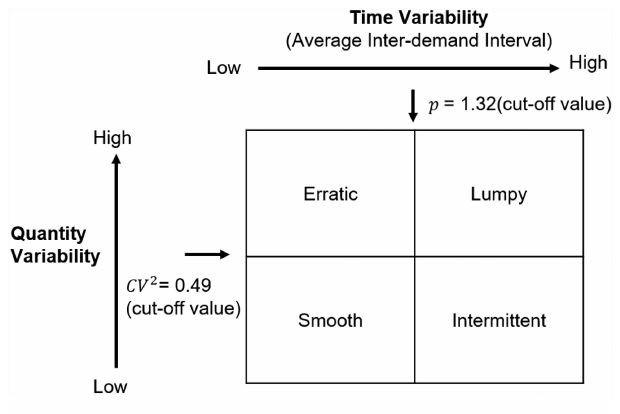
Figure 1. Demand classification scheme for intermittent